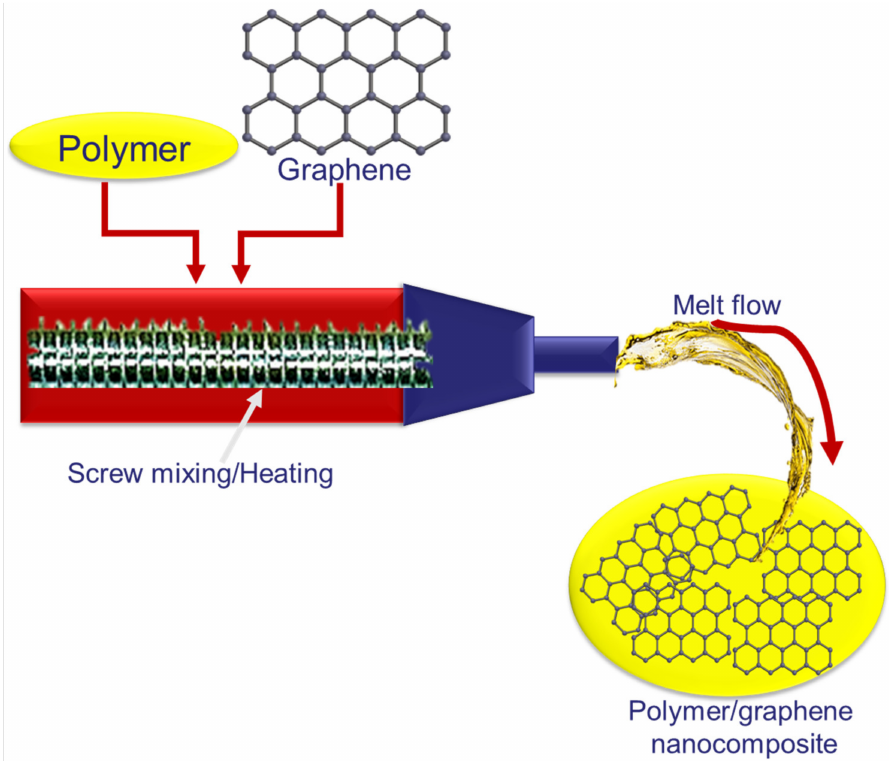
Figure 5. Melt compounding set-up of polymer/graphene